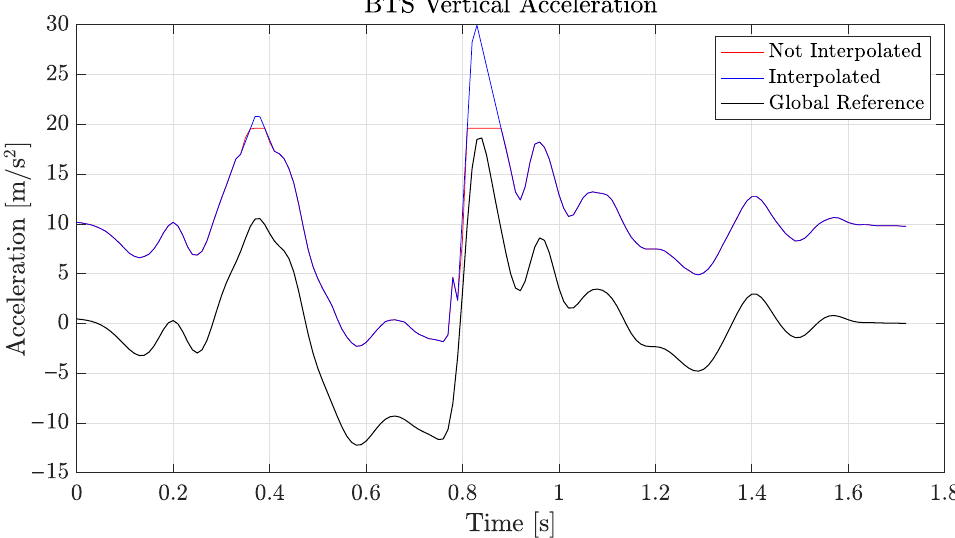
Figure 9. Interpolation of the vertical acceleration (BTS sensor limited to 20 m/s 2 maximum acceleration). In order to calculate the vertical speed (and, from that, the vertical position), a